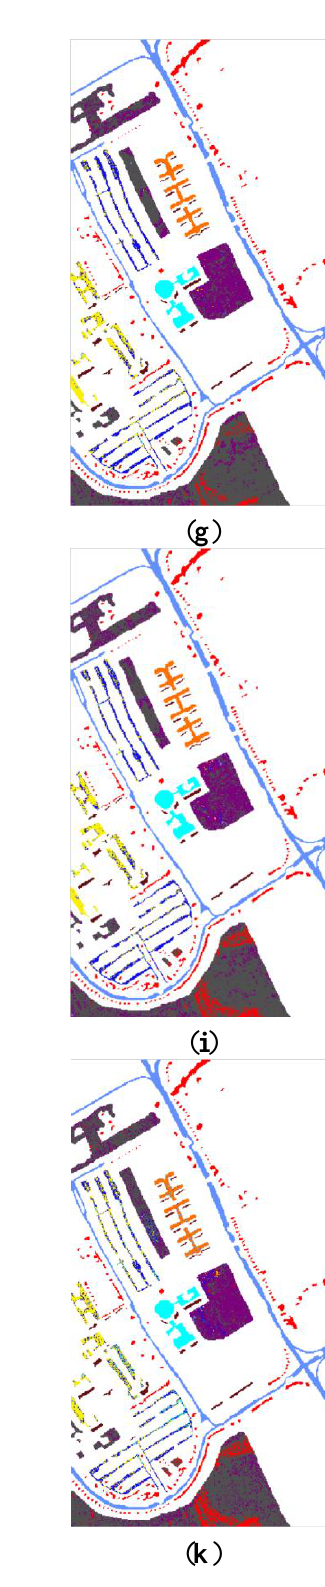
Figure 7. The classification maps of dataset Pavia University using various algorithms: ( a ) The ground truth; ( b ) FKNFLE; ( c ) KNFLE; ( d ) FNFLE; ( e ) NFLE; ( f ) NRS; ( g ) LFDA-NRS; ( h ) LFDA; ( i ) supervised LPP; ( j ) LDA; and ( k )